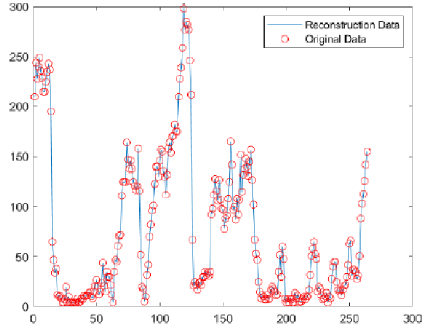
Fig. 2. Comparison between reconstructed data and original data of algorithm CL_BP.